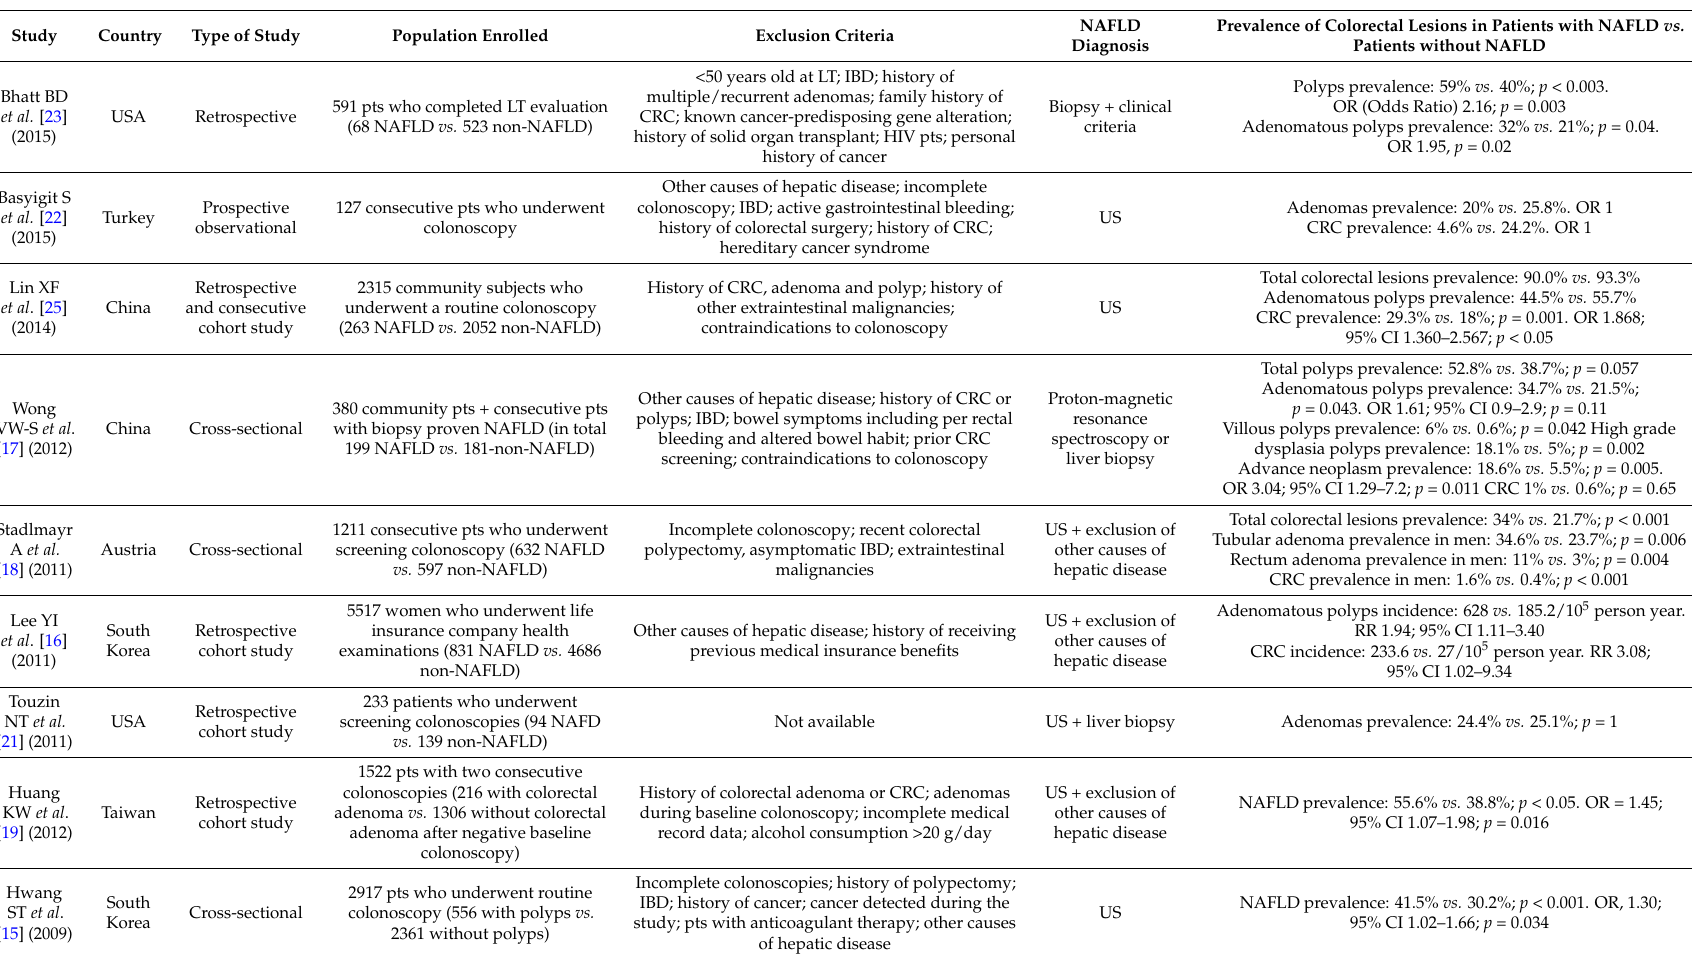
Table 1. Principal studies on the association between nonalcoholic fatty liver disease (NAFLD) and colorectal neoplasms